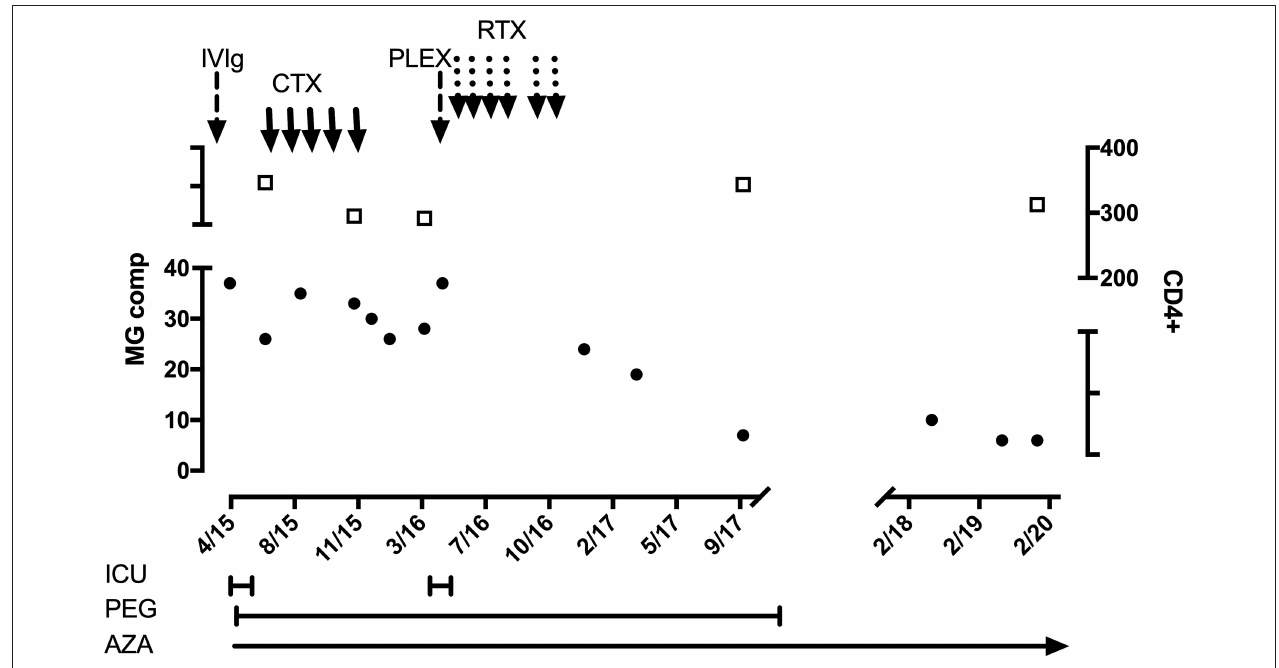
FIGURE 1 | HIV-infected patient with MuSK-MG. Black circles and left-sided y axis refers to MG composite score. Open squares and right-sided y axis refers to CD4 + count. ICU, intensive care unit; PEG, percutaneous endoscopic gastrostomy; AZA, azathioprine; IVIg, hyperimmune intravenous globulin; CTX, cyclophosphamide monthly pulses (250mg); PLEX, plasma exchange; RTX, rituximab infusions (500mg weekly × 4; and 2 weekly × 2 after 3